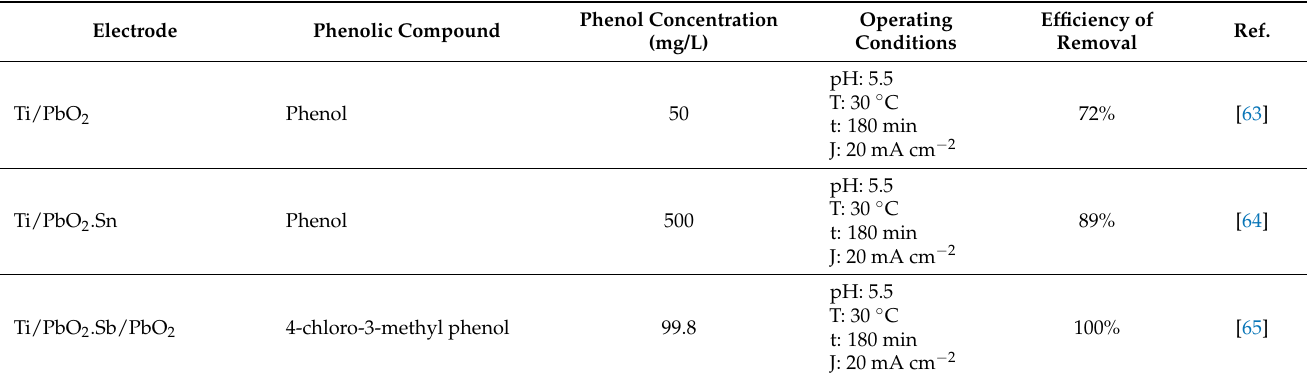
Comparison of phenol degradation study using different types of electrodes via the electrochemical oxidation